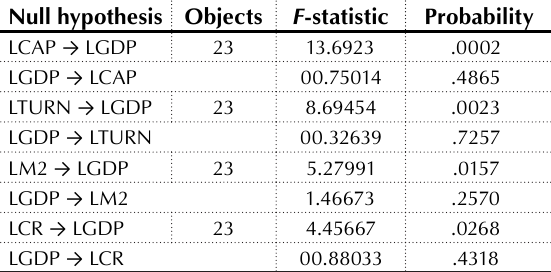
Table 6. Granger causality test results